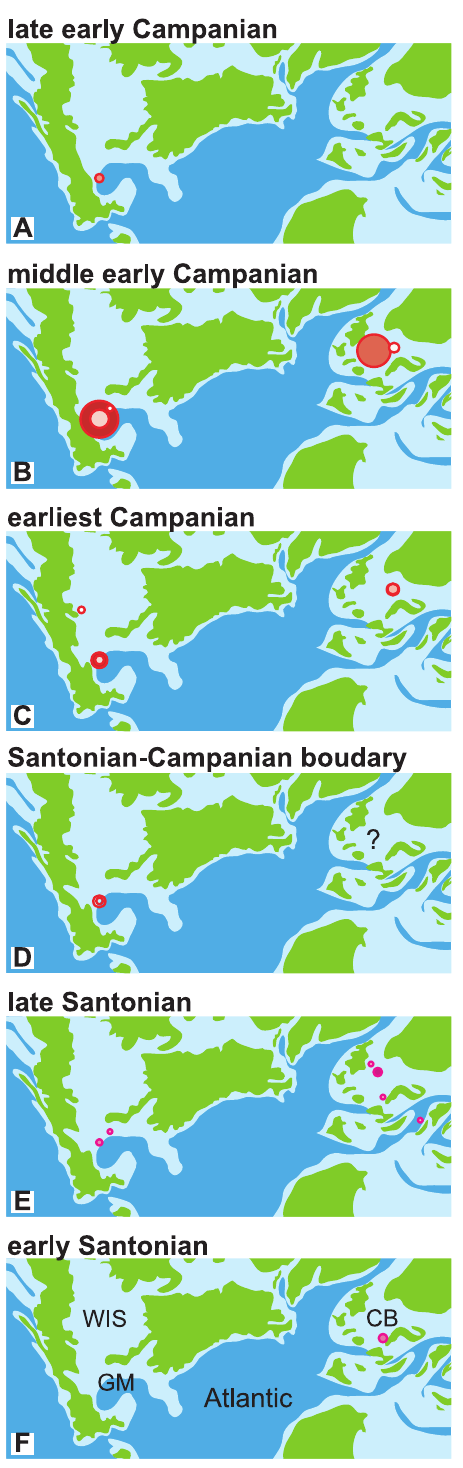
Fig 2. Distribution of giant Parapuzosia in the Santonian—Early Campanian. Area of dots approximates abundance of specimens. Abbreviations: CB: Cretaceous Basins of Europe, GM: Gulf of Mexico, WIS: Western Interior Seaway. Maps modified [from 8] under a CC BY license, with permission from deeptimemaps.org, original copyright 2016.